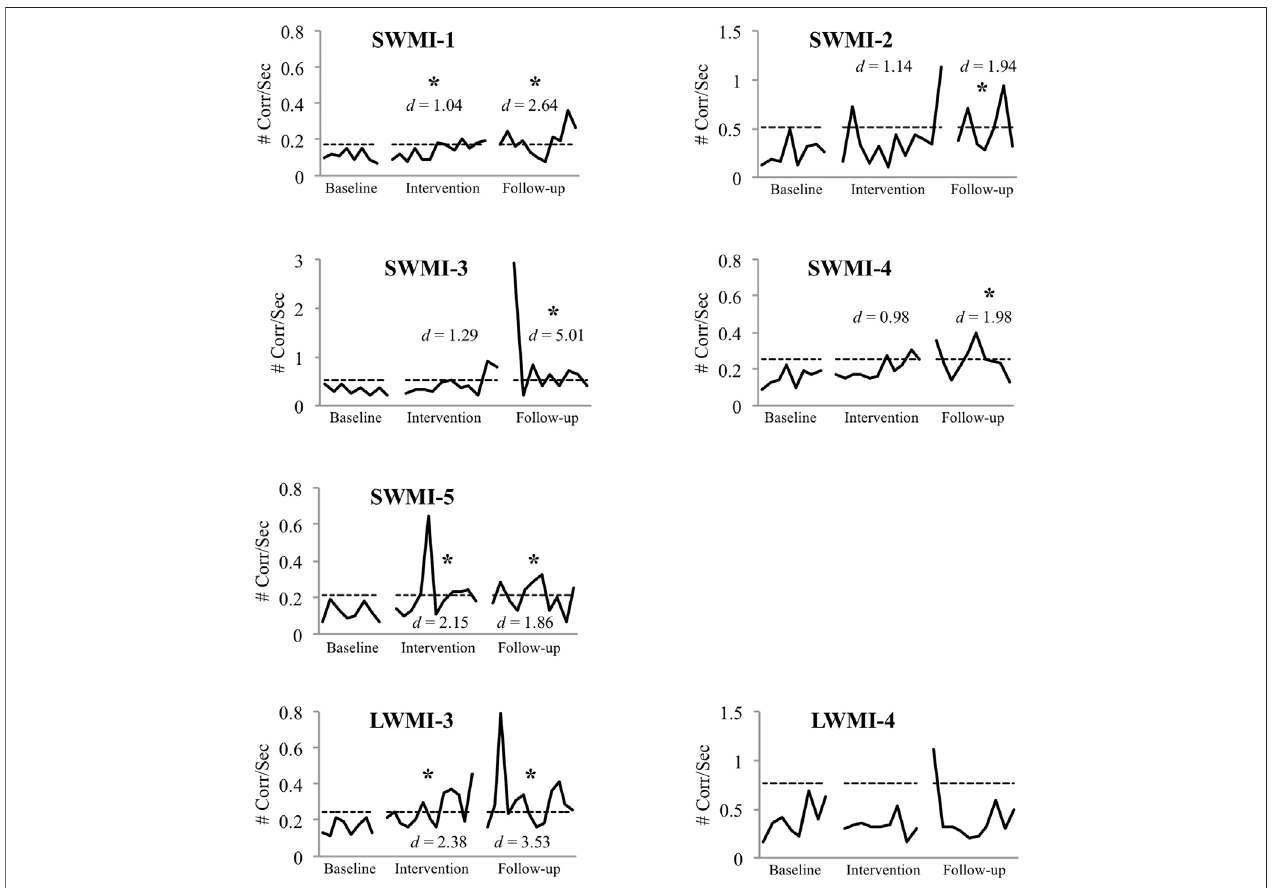
FIGURE3| Puzzlecompletionprobe.Graphspresentthecorrectnumberofshapesselectedpersecondaveragedoverallthreetrialsforeachsession.Dashedline represents 2 SD above mean score at baseline. Asterisks indicate signi fi cant improvement using 2 SD limit. All unmarked effect sizes d < 0.8.